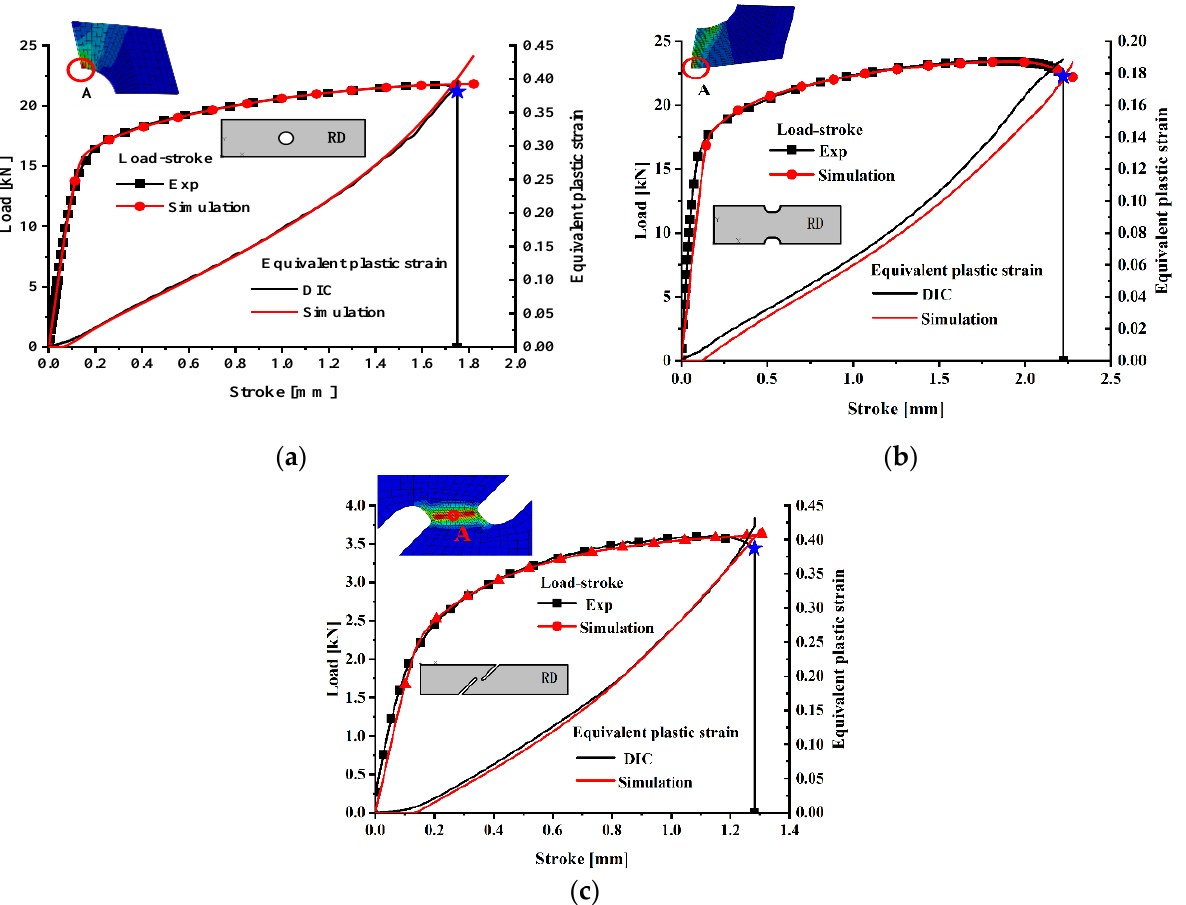
Figure 13. Comparisons of the experimental and simulated equivalent plastic strain to fracture: ( a ) specimen with a central hole; ( b ) notched specimen; ( c ) in-plane shear specimen.